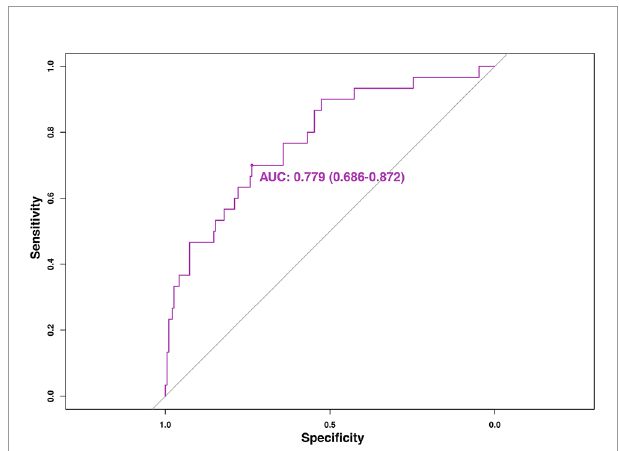
FIGURE 5 | The ROC of the nomogram for predicting regrowth in patients with benign thyroid nodules after RFA. AUC for the nomogram to predict regrowth was 0.779 (95%CI 0.686 – 0.872).